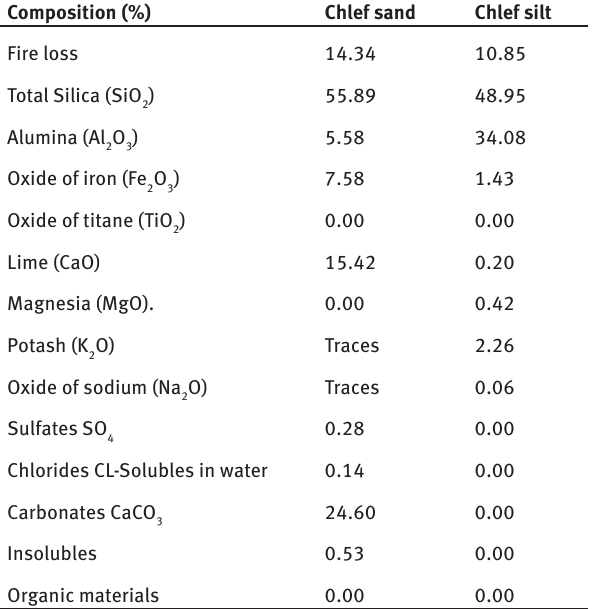
Table 2: Chemical analysis of tested materials